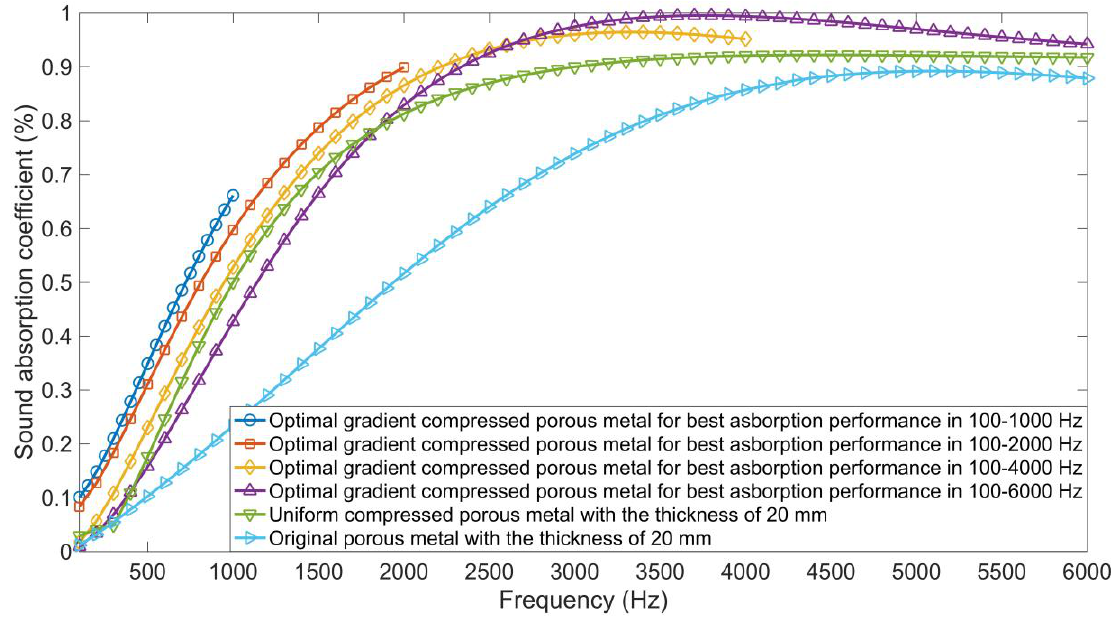
Figure 1. Comparisons of sound absorption coefficients of the optimal 10-layer gradient compressed porous metals and those of the original porous metal and uniform compressed porous metal.